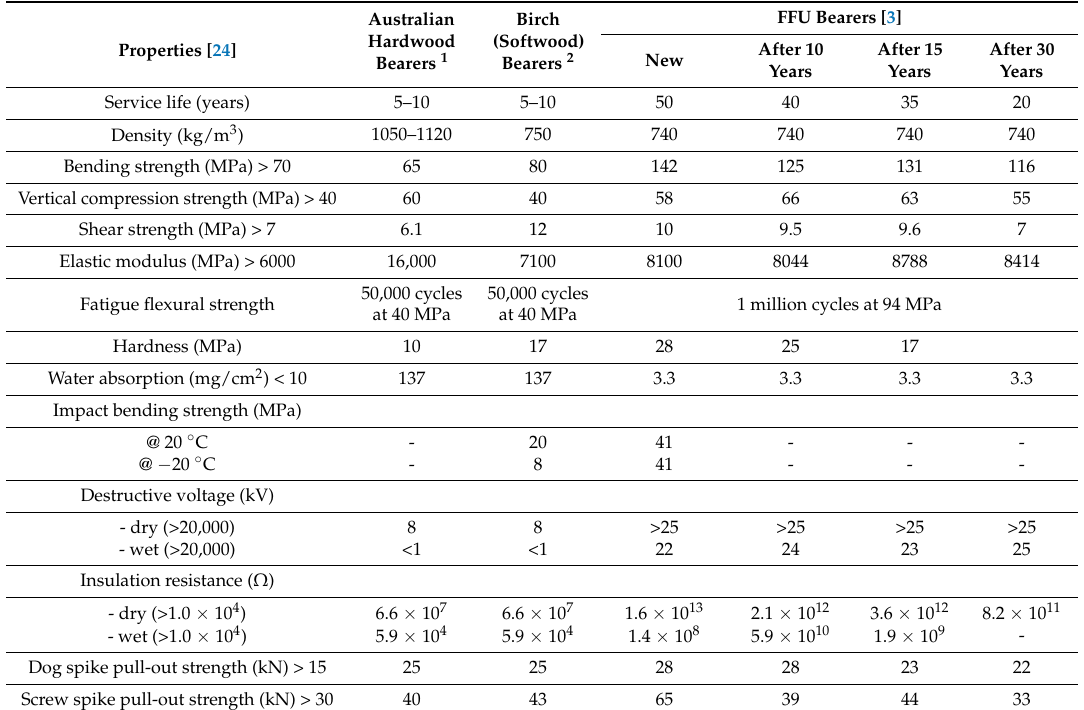
Table 3. Basic properties of FFU material in comparison with timber